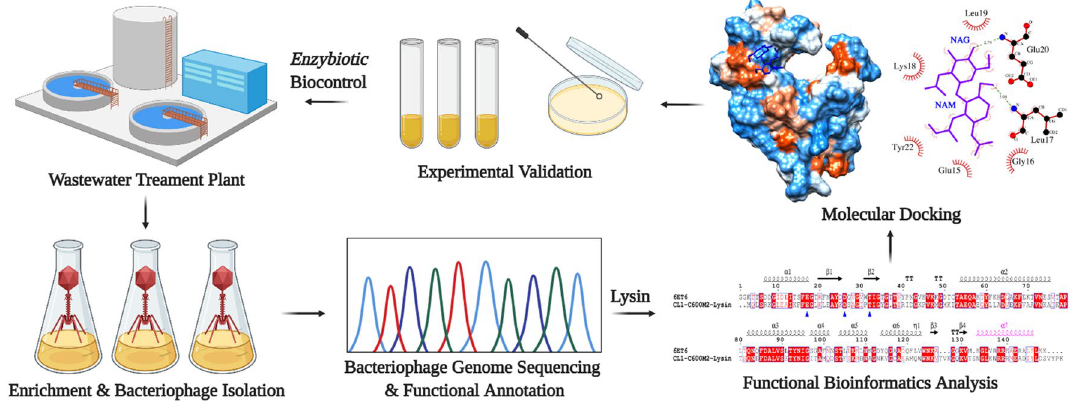
Figure 1. Summary of the research study. Wastewater samples were drawn from main wastewater treatment plant in Qatar, followed by enrichment and isolation of inherent bacteriophages, whole genome sequencing using Ion Torrent S5 next-generation sequencing (NGS) platform and functional annotation of the assembled bacteriophage genome. Gene products annotated as lysins were further analyzed for their potentiality as “enzybiotics” by in silico and experimental studies. This schematic representation was created with BioRender.